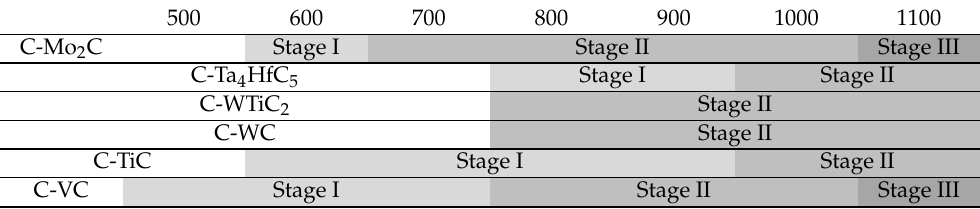
Table 3. Carbide derived carbons divided by the graphitization stages based on the Raman